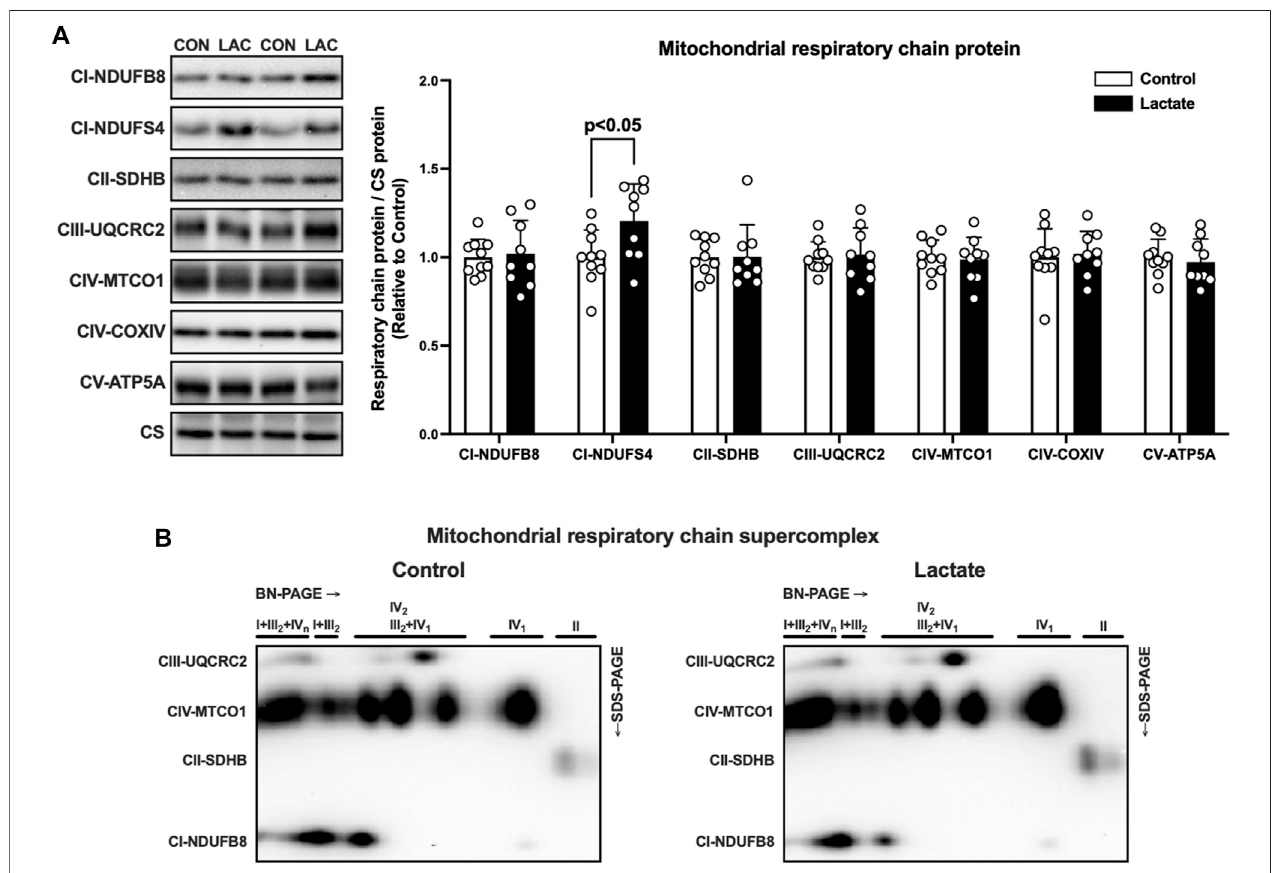
FIGURE 4 | The protein content ofrespiratory chain components (A) and supercomplex assembly (B) in isolated mitochondria. Data are expressed as mean ± SD and are normalized to citrate synthase (CS) protein. Control group: n = 10, Lactate group: n = 9. Unpaired Student ’ s t-test was used for statistical evaluation.